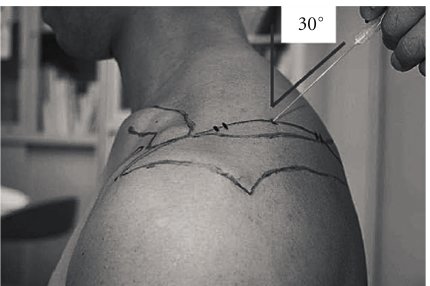
Figure 12: Matsumoto technique for the suprascapular nerve block. Needle insertion point is the midpoint of a line connecting the anterolateral edge of the acromion and the superomedial angle of the scapula. The needle is advanced, at an angle 30 ◦ dorsal to the coronal plane, to make contact with the base of coracoid process (Matsumoto et al. [5]). (Reprinted with permission from Elsevier.)